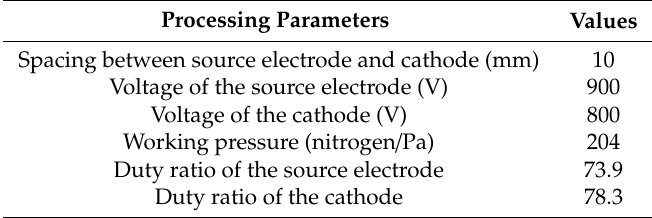
Table 1. The processing parameters of double glow plasma surface alloying (DGPSA) treatment. Processing